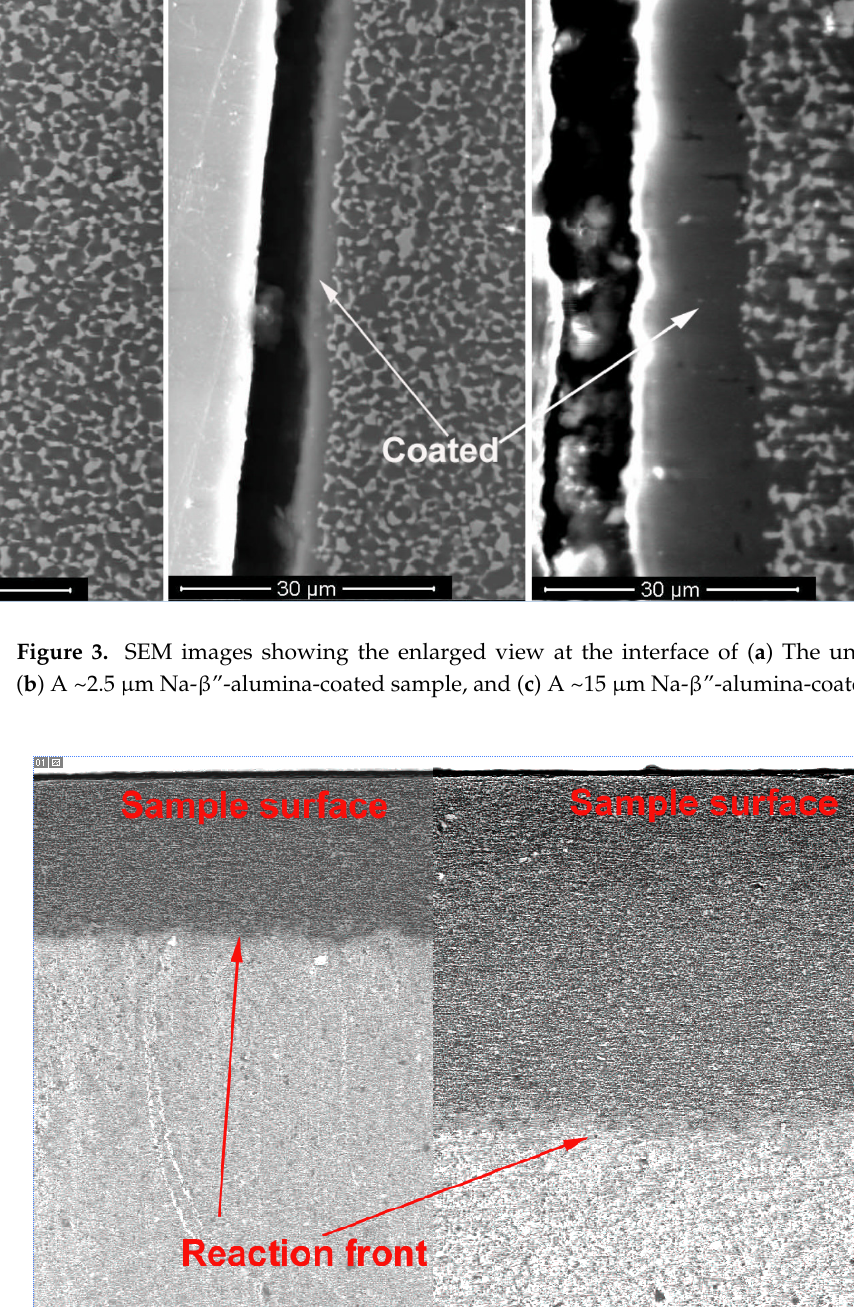
Figure 4. SEM images showing the conversion fronts for the uncoated and 2.5 µ m Na- β ”-alumina- coated regions after 6 h of